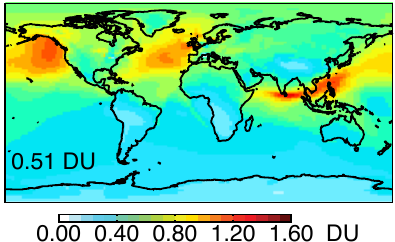
Figure 4. Annual-mean O 3 column enhancements due to ship NO x emissions with parametric plume chemistry. Values are calculated from a 5% emission perturbation and multiplied by 20. Inset num- ber gives the global-mean change. Patterns are similar in the instant dilution simulation, but with fixed OPE, the O 3 enhancements shift toward high northern latitudes (Fig.